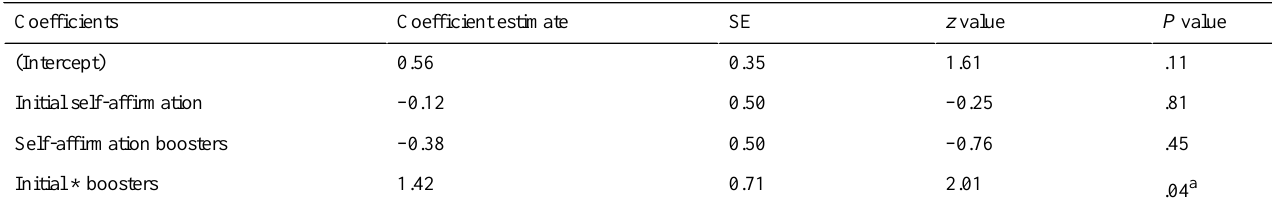
Table 1. Coefficients for the logistic regression model of goal adherence.